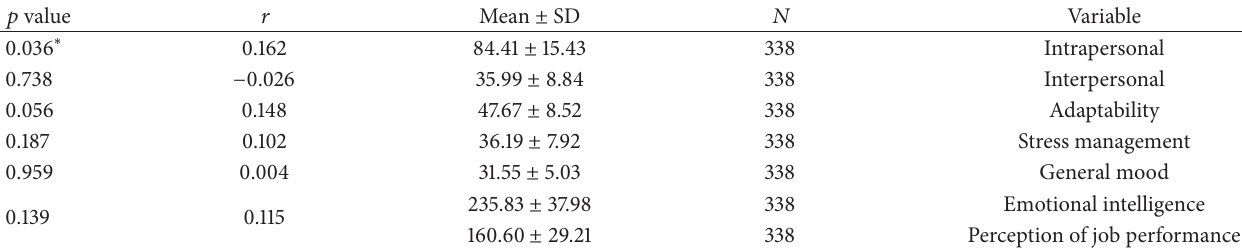
Table 1: Relationship between perception of job performance with nurses’ emotional intelligence and its